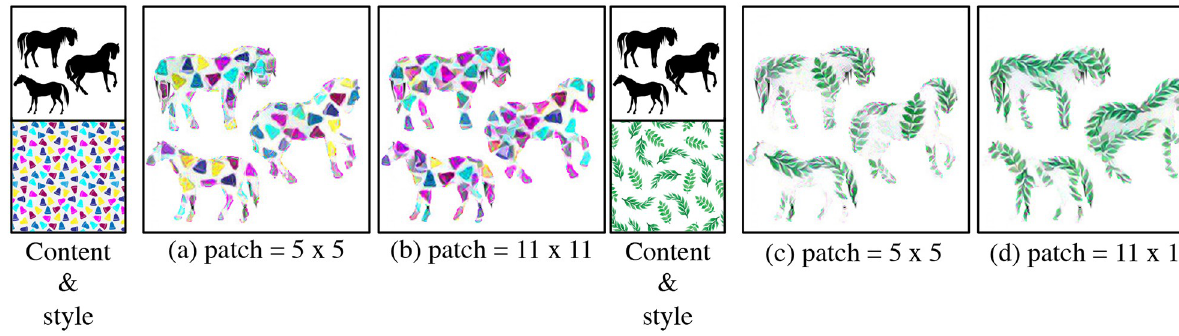
Fig 13. The effects of patch size that used in the proposed method.